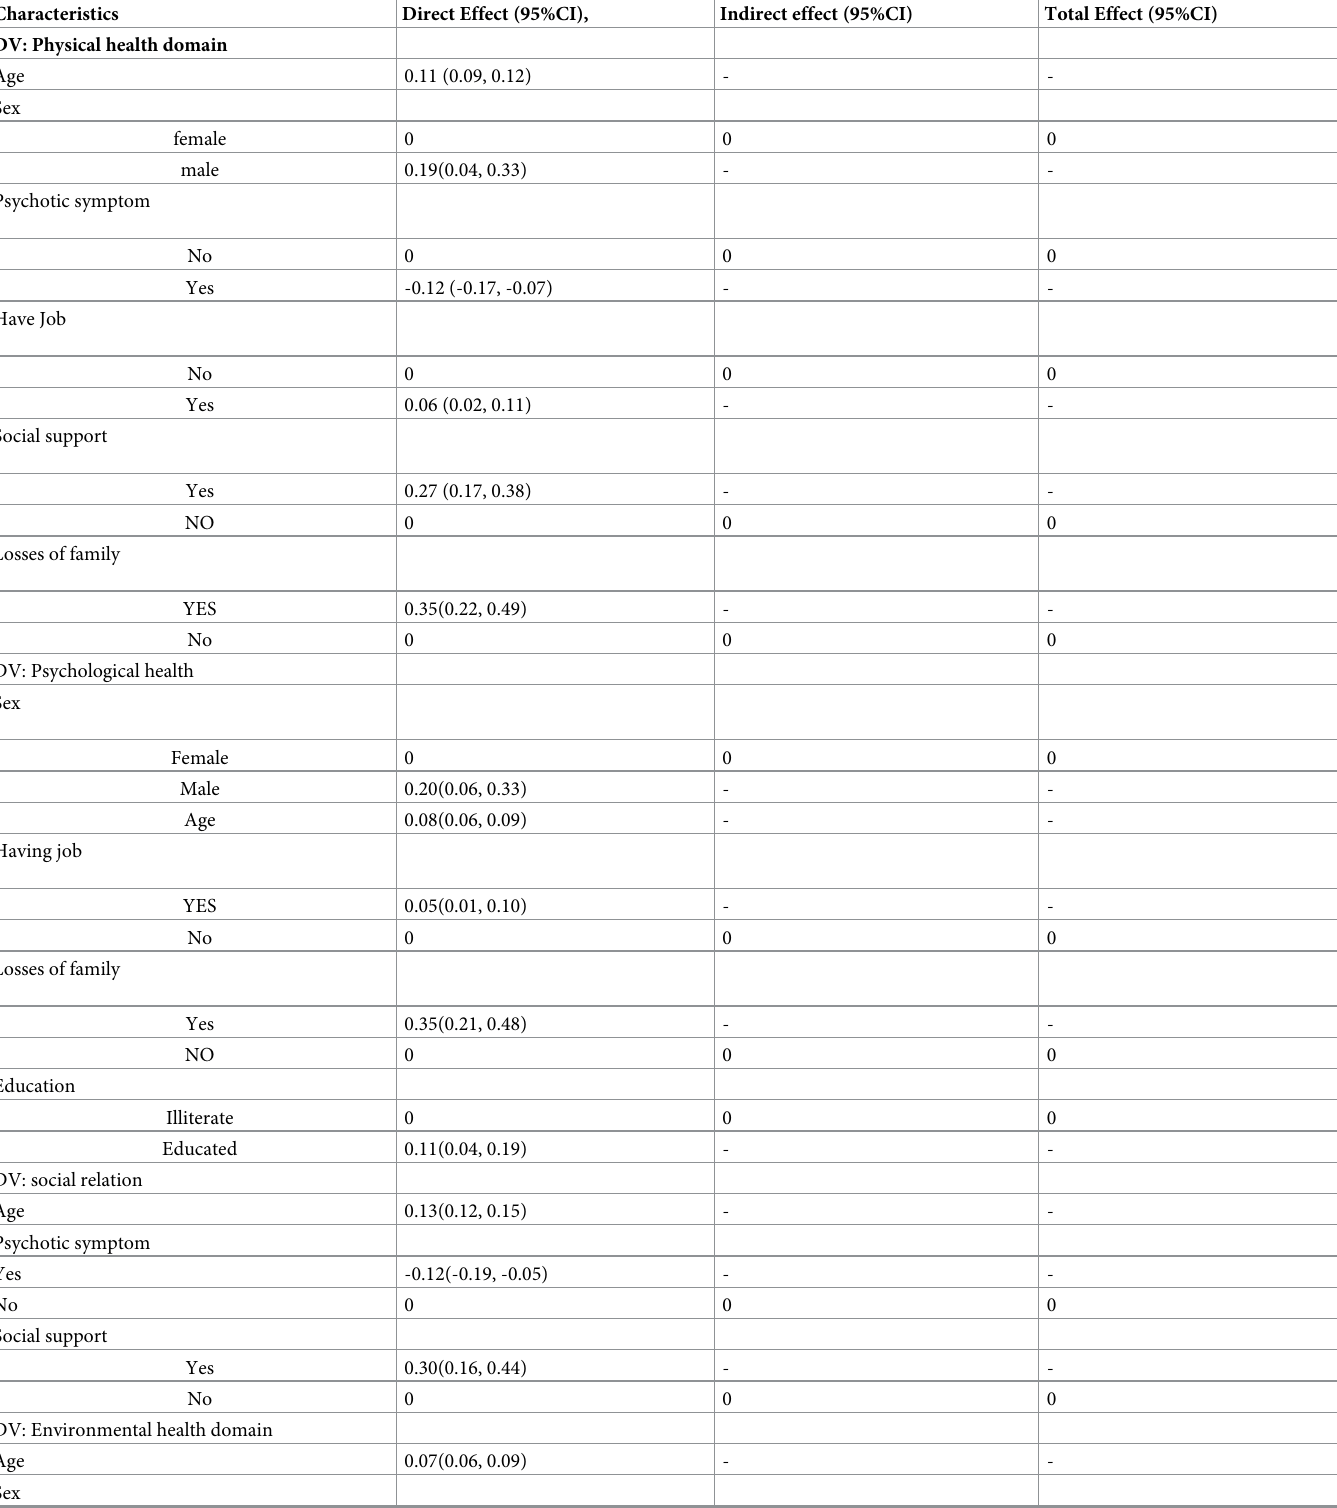
Table 3. The direct, indirect, and total effect of socio-demographical and clinical factors on HRQOL domains among youth who use substances.